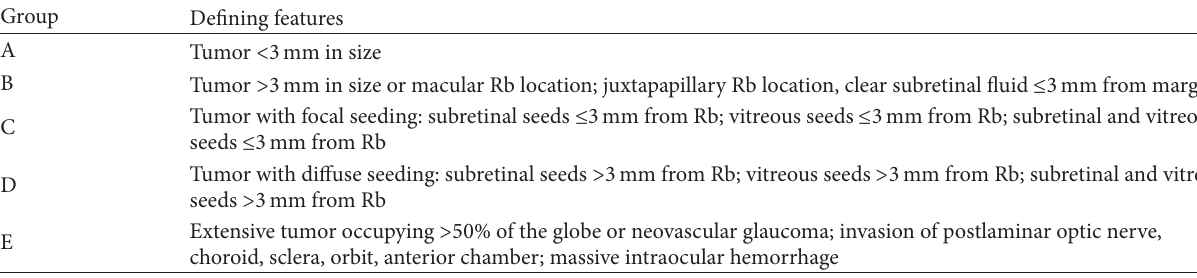
Table 1: The International Classification of Retinoblastoma (IRCB)